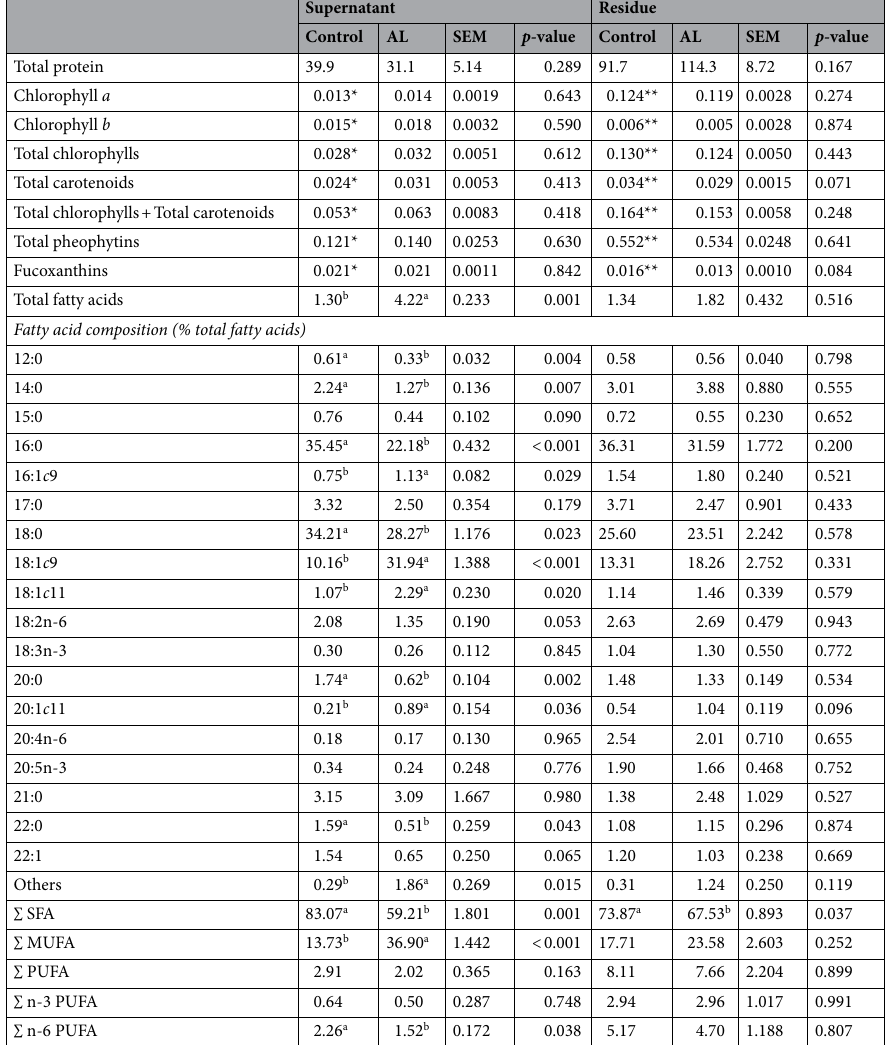
Table 4. Content (mg/g alga) of total proteins, chlorophylls, carotenoids, fucoxanthins and fatty acids of the supernatant and residue fractions derived from the incubation of Laminaria digitata with control and alginate lyase (AL; ID 22) treatment. Two mL of macroalgae suspension was incubated with alginate lyase at a final concentration of 20 mg/L. The control assay took the same amount of PBS. Incubations were done overnight at 37 ºC and 160 rpm. After incubations, supernatant and residue fractions were separated by centrifugation. Only fatty acids whose percentage was > 0.5% are presented. * Values measured in phosphate buffered saline (PBS); ** Values measured after extraction with